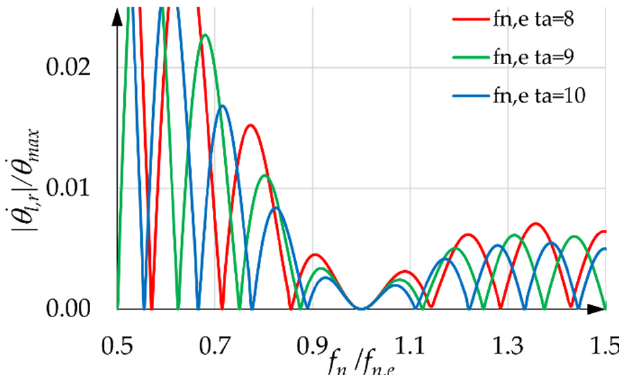
f t equal to five, six, and seven. n,e a